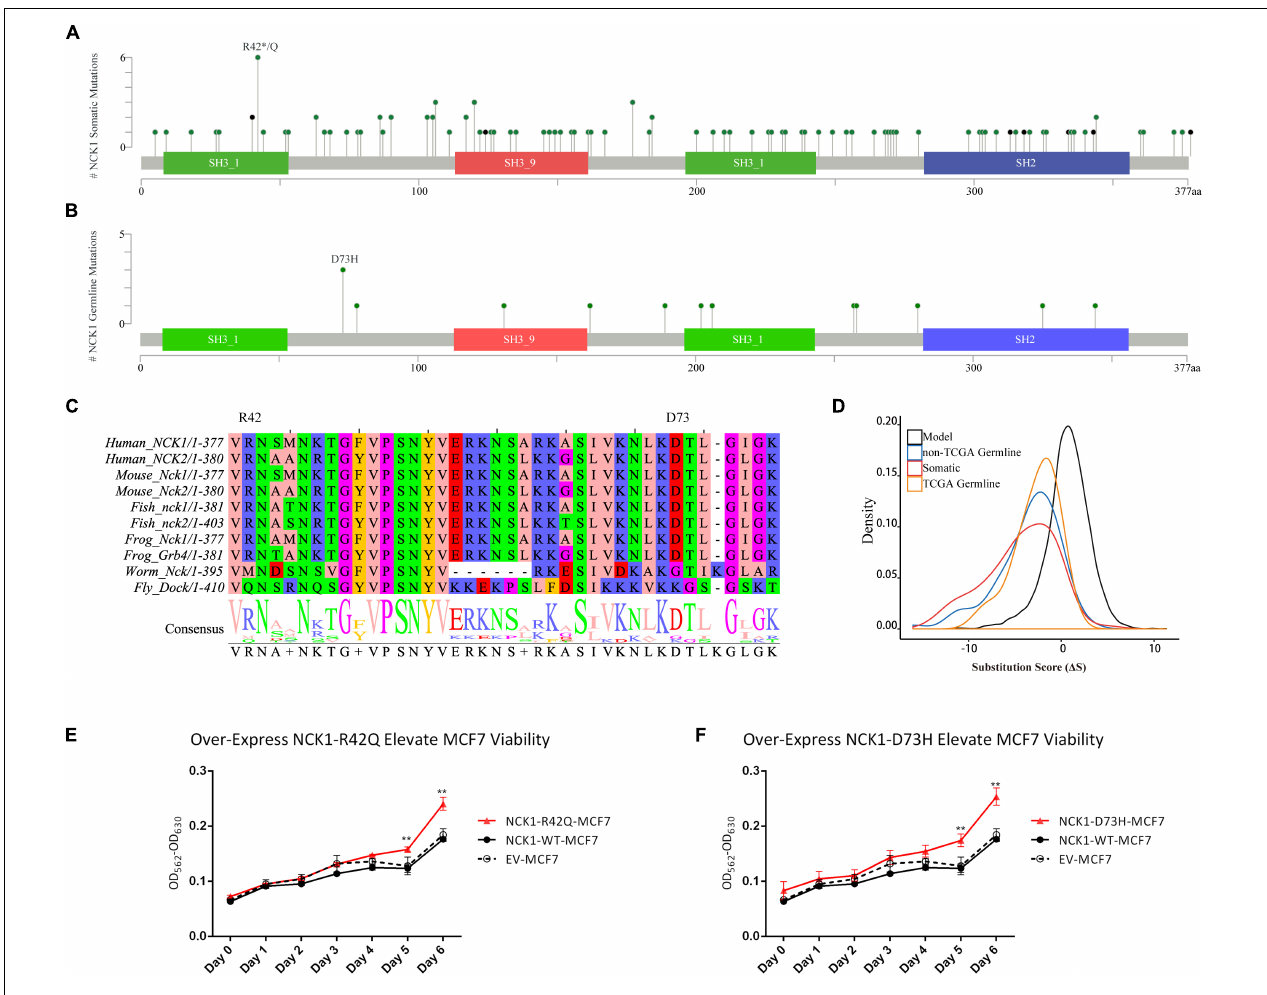
FIGURE 1 | NCK1 mutation diagram and potential functional effect. (A) Mutation diagram of NCK1 collected in cBioportal (Pan-Cancer). (B) Mutation diagram of germline mutations in NCK1 , including all TCGA-germline variants and NCK1 D73H, identified in familial breast cancer pedigree (F2887). (C) Multiple sequence alignment of sequence flanking NCK1 D73 residue. (D) Distribution of substitution score ( (cid:49) S) of NCK1 based on Position Specific Score Matrix. (E and F) The cell viabilities in all groups of mutant over-expression assay about R42Q (E) and D73H (F) at different time points (0, 1, 2, 3, 4, 5, and 6 days). Data were expressed as mean ± standard deviation (SD) of experiments with triplicates. Asterisks indicate significant increasing of cell viability in mutant (R42Q and D73H) transfected MCF7 cells compared with wild type transfected MCF7 cells (Student’s t -test; P < 0.01). Model: random mutations generated by in silico , non-TCGA germline: variants collected in ExAC non-TCGA dataset; TCGA-germline: variants collected in ExAC, but not in the ExAC non-TCGA dataset; Somatic: somatic variants collected in